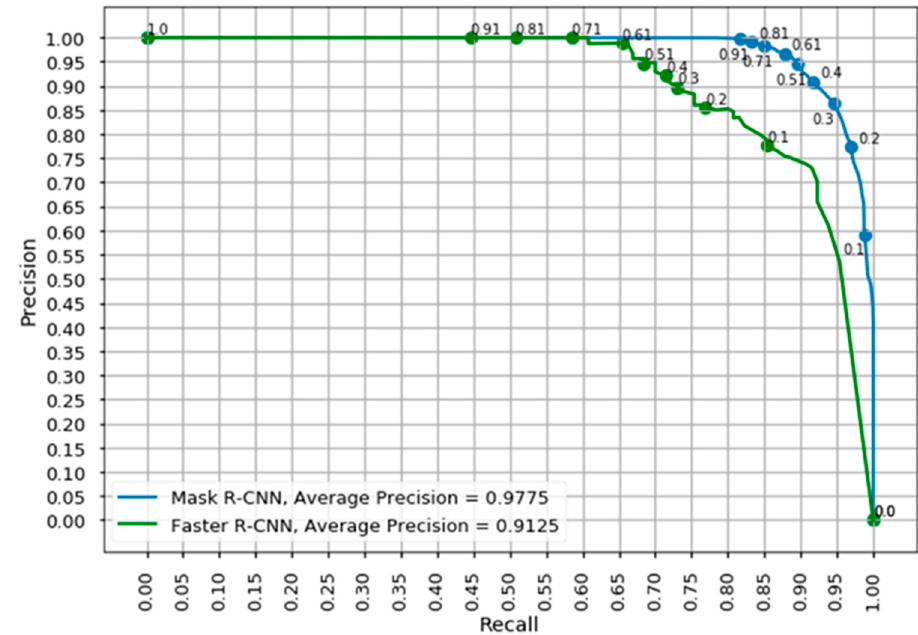
Figure 8. Precision and recall curves for Faster R-CNN and Mask R-CNN Carolina Bay detectors.